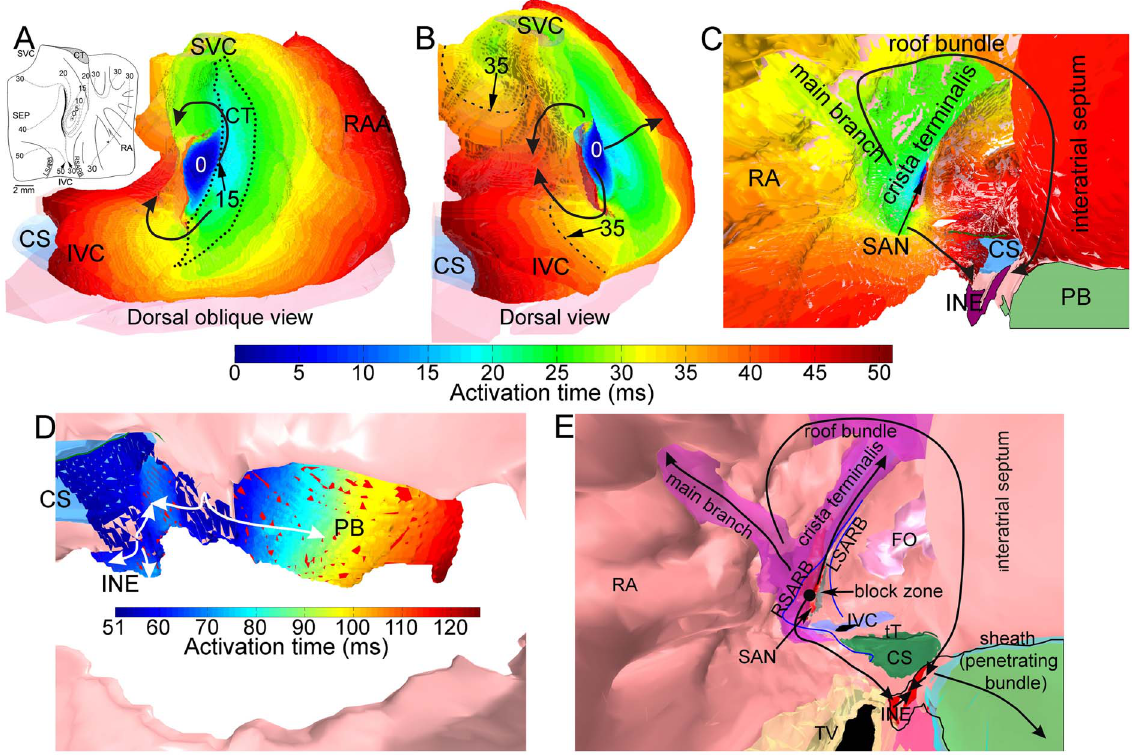
Figure 5. The sequence of right atrial activation during normal sinus rhythm in the 3D model of the rabbit right atrium. A–E, external (A, dorsal oblique view and B, dorsal view) and internal (C–E) views of the model. In A, the crista terminalis is outlined by a dotted line. In B, the dashed line is an example isochrone at 35 ms. In A to D, the activation sequence is shown by a colour scale and the arrows show the direction of action potential conduction. In E, different segmented structures are shown in different colours and the arrows summarise action potential conduction from the SAN to the AVN. CS, coronary sinus; INE, inferior nodal extension; IVC, inferior vena cava; FO, fossa ovalis; LSARB, left sinoatrial ring bundle; PB, penetrating bundle; RA, right atrium; RAA, right atrial appendage; RSARB, right sinoatrial ring bundle; SVC, superior vena cava; TV, tricuspid valve. doi:10.1371/journal.pone.0112547.g005 PLOS ONE |